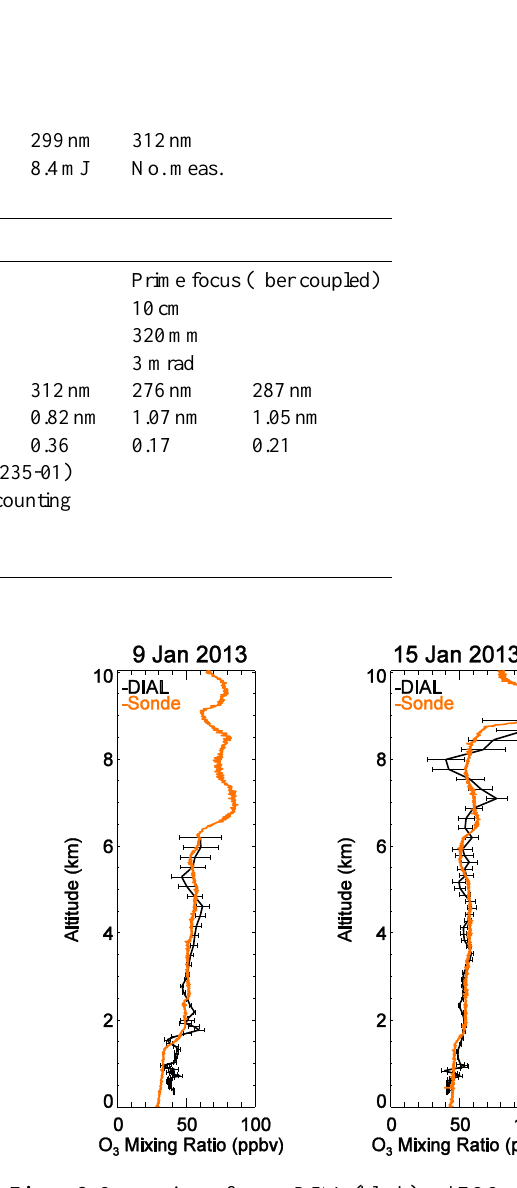
Figure 3. Comparison of ozone DIAL (black) and ECC ozonesonde (orange) measurements on 9 (left panel) and 15 January (right panel) in 2013. The error bars of ozone DIAL data show the sta- tistical errors calculated from the lidar signal to noise